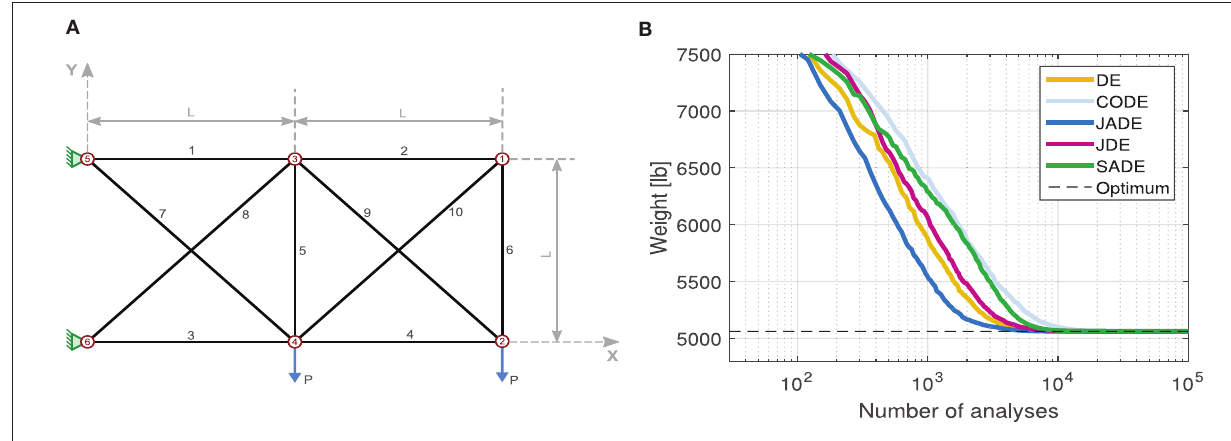
FIGURE 2 | 10-bar plane truss (A) geometry; (B) algorithms’ convergence histories (average of 30 runs). TABLE 5 | Algorithms’ statistical parameters for the 10-bar plane truss problem.